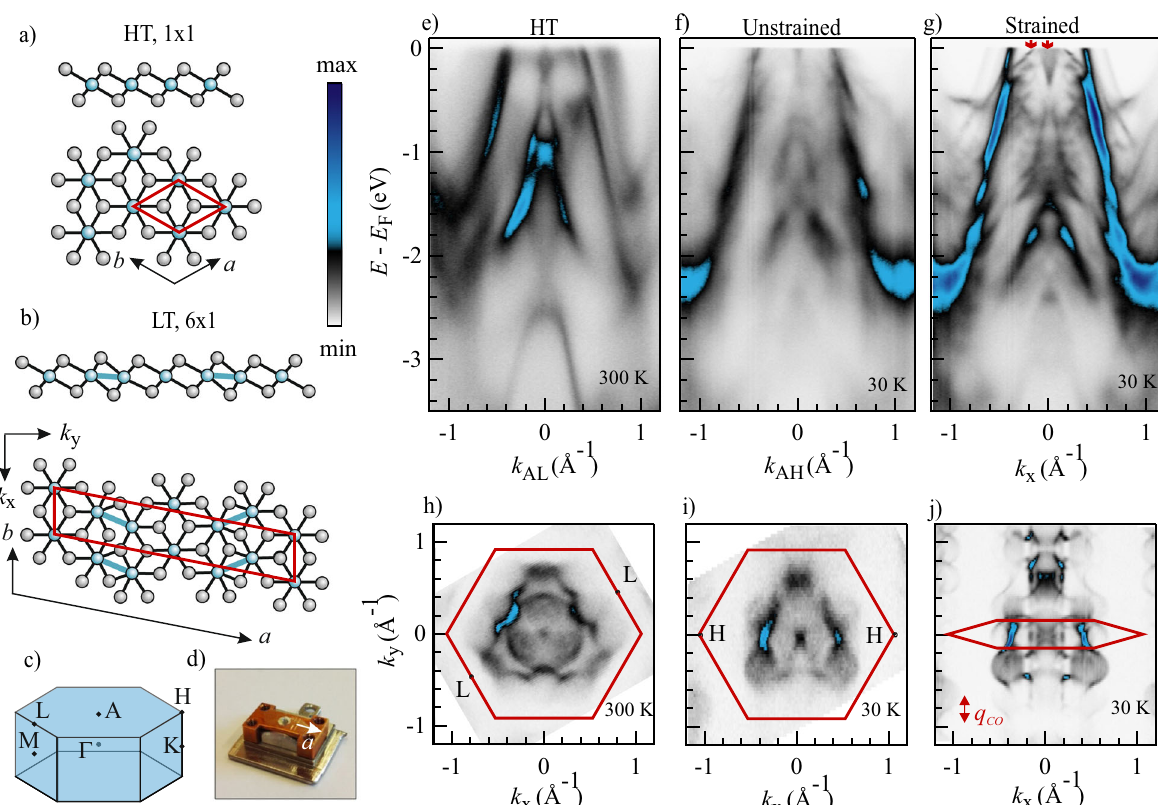
Fig. 1 Effect of strain on the electronic structure of IrTe 2 . a , b Top and side views of the crystal structure of IrTe 2 in the high-temperature 1 × 1 ( a ) and low-temperature 6 × 1 phase ( b ). The formation of Ir – Ir dimers is highlighted by solid blue lines. Red lines are the unit cells of the corresponding phases. The experimental k x and k y directions are marked. c Bulk Brillouin zone of the high-temperature phase showing the high-symmetry points. d Photograph of the strain device. Samples are oriented to have strain along the a -direction of the high-temperature phase. e – g ARPES measurements ( h ν = 90.5 eV) of ( e ) the high-temperature unstrained sample obtained along the LAL direction of the bulk Brillouin zone, ( f ) the low-temperature ( T = 30 K) unstrained sample obtained along HAH and g in the low-temperature strained sample. The cut along k x in ( g ) corresponds to along the Ir-dimer chain direction i.e., the ×1 direction of the 6 × 1 unit cell ( b -axis in real space). The intensity scale encodes the photoemission intensity measured in the experiment, which is proportional to the one-particle removal function, A − ( k , ω ). h – j corresponding Fermi surfaces for the three cases in ( e ) – ( g ). The corresponding Brillouin zones for the 1 × 1 and 6 × 1 phases are overlaid. Additional constant energy cuts are shown in Supplementary Fig. S1. Cuts along the k y direction (charge ordering direction, q CO ) revealing the 6 × 1 period are shown in Supplementary Fig. reveals that the 6 × 1 phase is found over a continuous region of dimensions ~0.5 × 0.4 mm 2 .